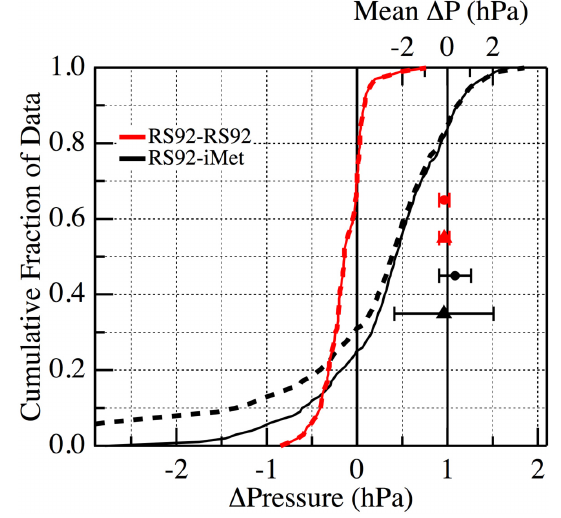
Fig. 8. CDFs and Gaussian statistics for RS92-RS92 1P (red) and RS92-iMet 1P (black) that present the same information as for 1T in Fig. 4. The red dashed and solid curves are identical because none of the RS92-RS92 1P profiles are anomalous. Though the CDFs of RS92-iMet 1P are offset positively by about 0.5hPa, their stan- dard deviation ranges and inner-68% ranges indicate no significant